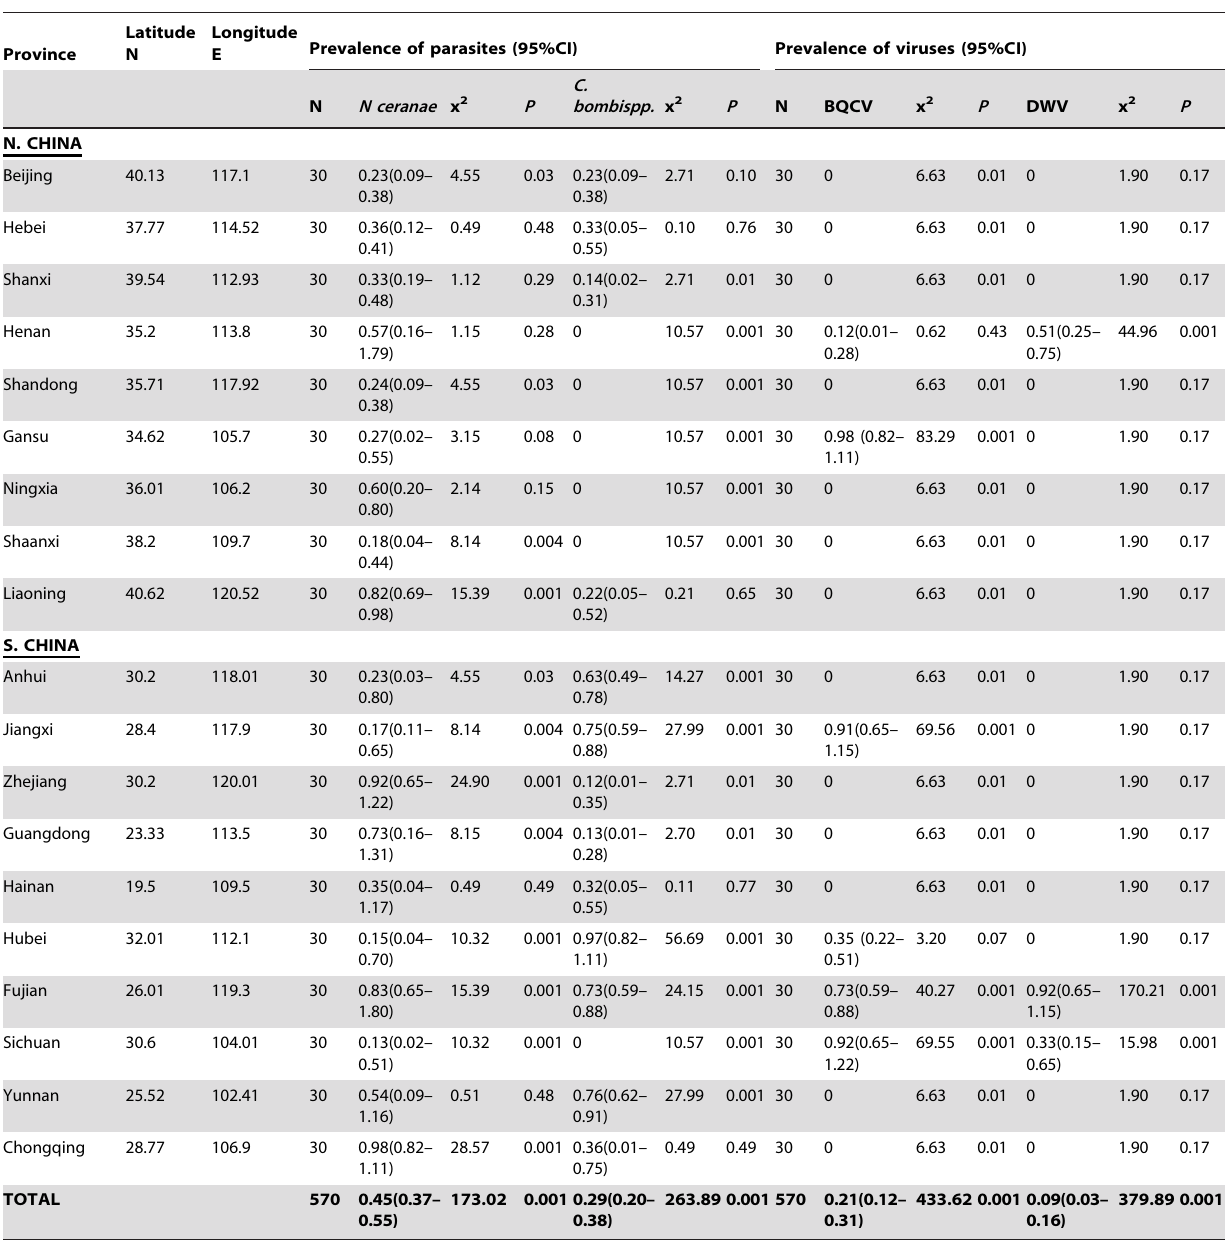
Table 2. Synopsis of collection details and prevalence of parasites in A. cerana colonies from 19 provinces in China.